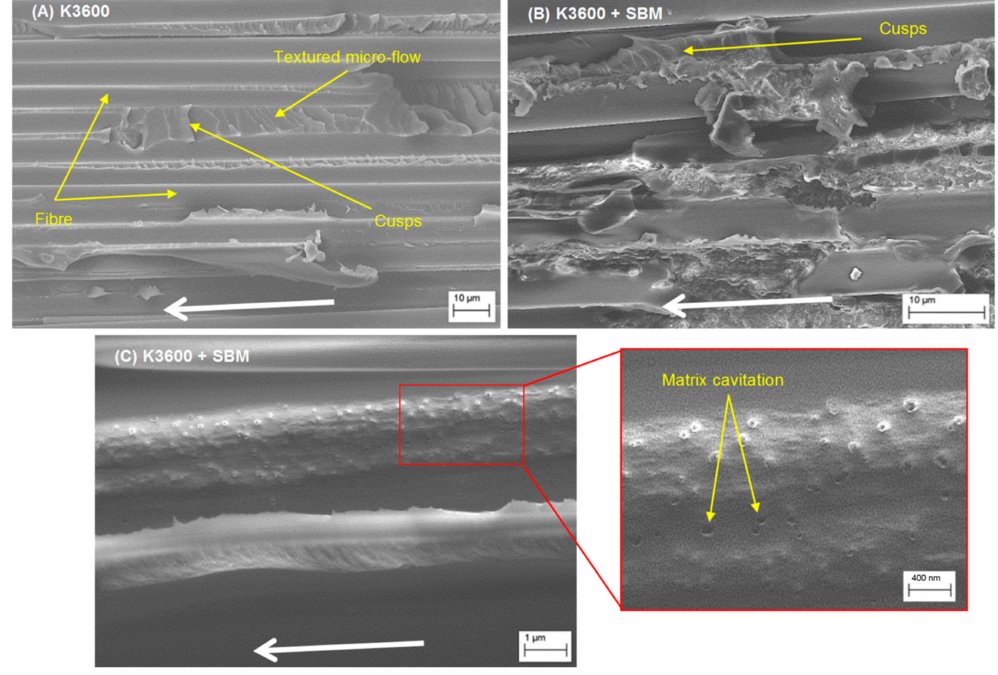
Figure 12. Scanning electron micrographs (SEM) of Neat ( A ) and SBM-toughened ( B , C ) fracture surfaces excised from DCB specimens slightly ahead of the final crack tip length. The white arrows show the crack propagation